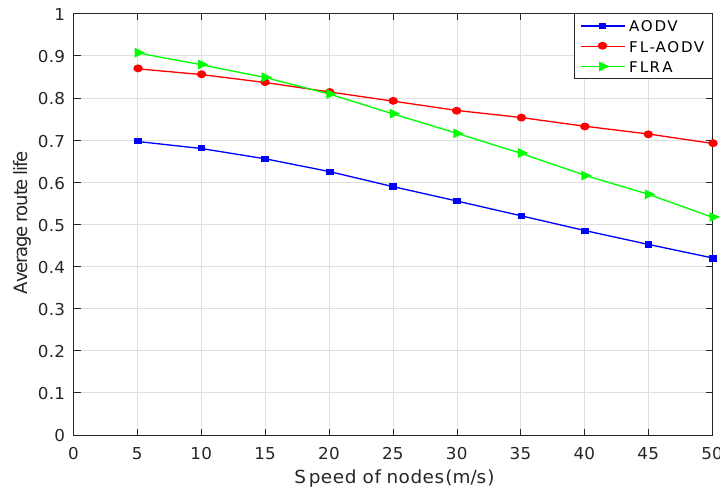
Figure 14. Comparison of average route life at different